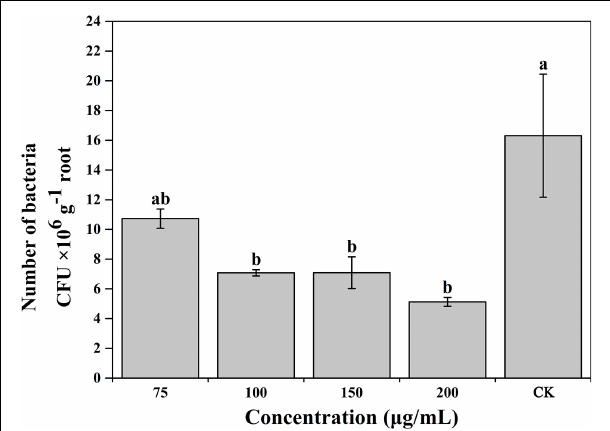
FIGURE 7 | Influence of caffeic acid on R. solanacearum colonization of tobacco roots. The error bars indicate the standard errors from three independent replicates, and the lowercase letters indicate significant differences identified according to Duncan’s test ( p < 0.05).